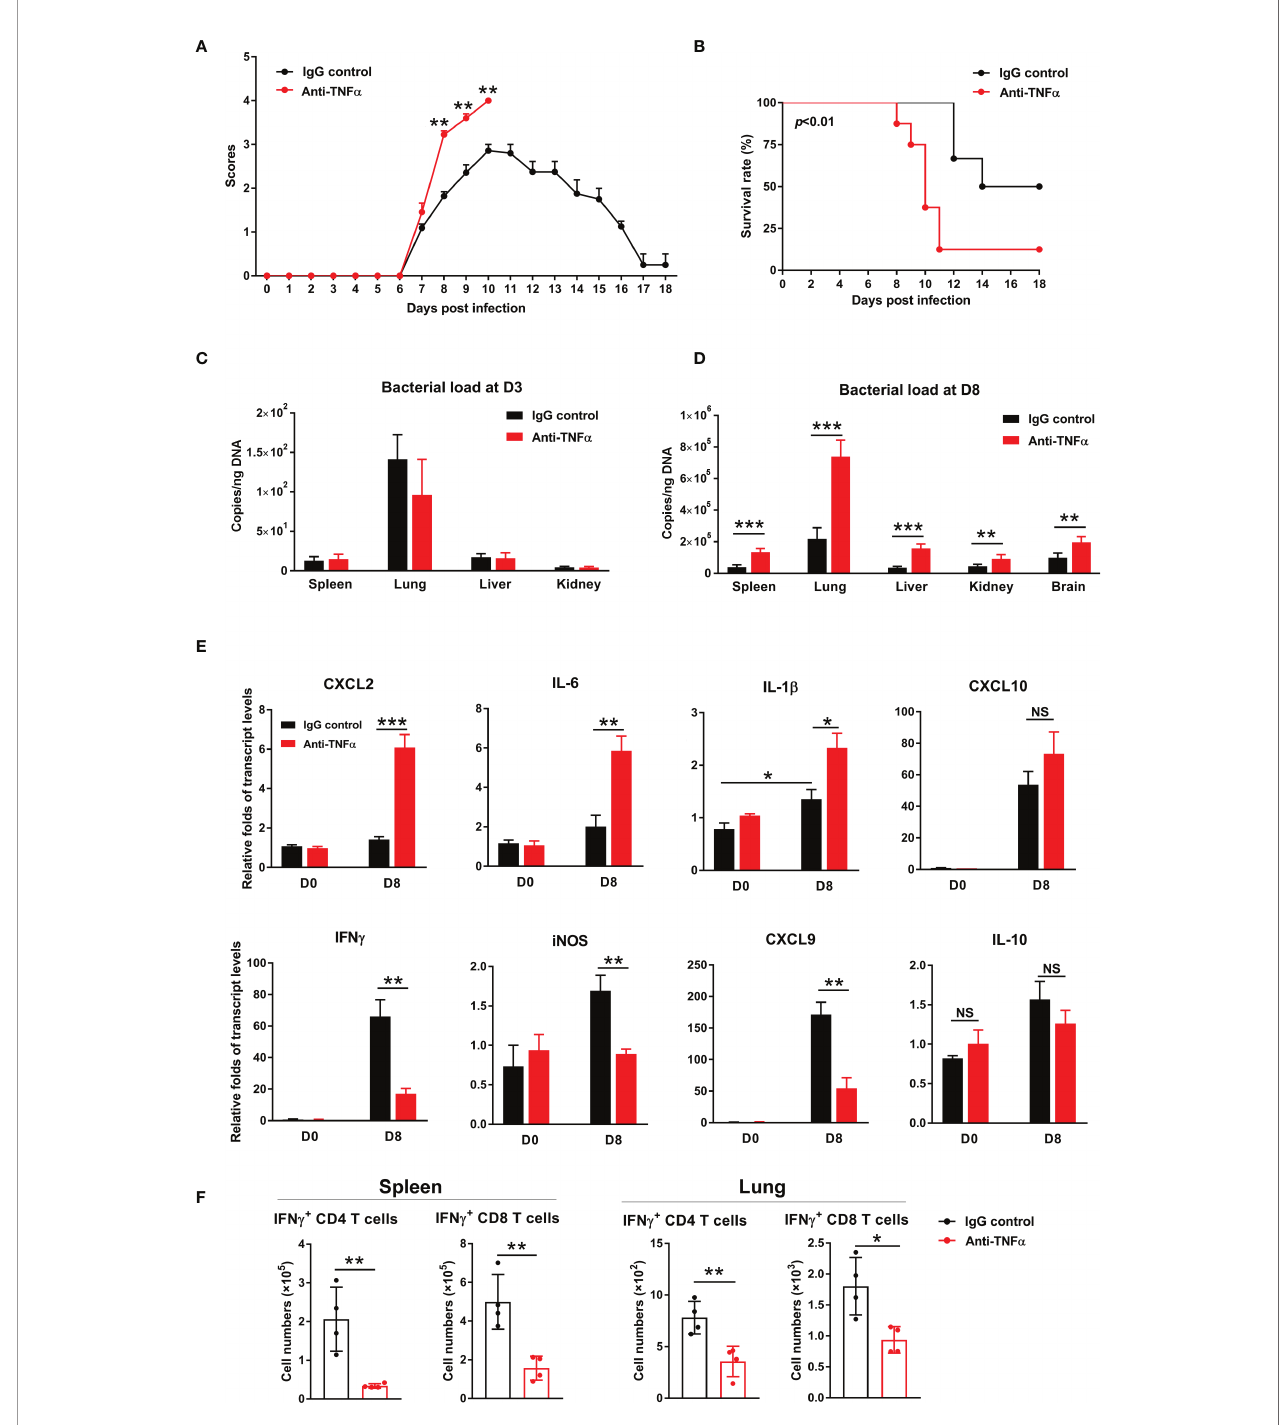
FIGURE 6 | TNF- a neutralization increased host susceptibility to infection and exacerbated in fl ammatory responses. WT mice were infected i.v. with 6 × 10 4 FFU of bacteria, as in Figure 1 . Mice were treated with anti-TNF- a antibody every other day starting from D1 (200 µg/mouse, i.p. ). Rat IgG was used as an isotype control. (A) Clinical scores and (B) survival curves (10 mice/group) were recorded daily. (C, D) Bacterial loads in indicated organs at D3 and D8 were measured by qPCR (4- 5 mice/group). (E) Transcript levels of cytokines and chemokines at D8 were analyzed by qRT-PCR. (F) Lymphocytes were isolated from the spleen and lungs and stimulated with TSA56 protein (10 µg/mL) ex vivo overnight in the presence of brefeldin A for the last 4 h. Cells were harvested for intracellular staining of IFN- g and analyzed by fl ow cytometry. Data are shown as mean ± SD from single experiments and are representative of two independent experiments performed. A two-tailed student t test was used for comparison of two groups. Survival data were analyzed using a log-rank (Mantel-Cox) test. * p <0.05; ** p <0.01; *** p <0.001; **** p <0.0001; NS, not signi fi